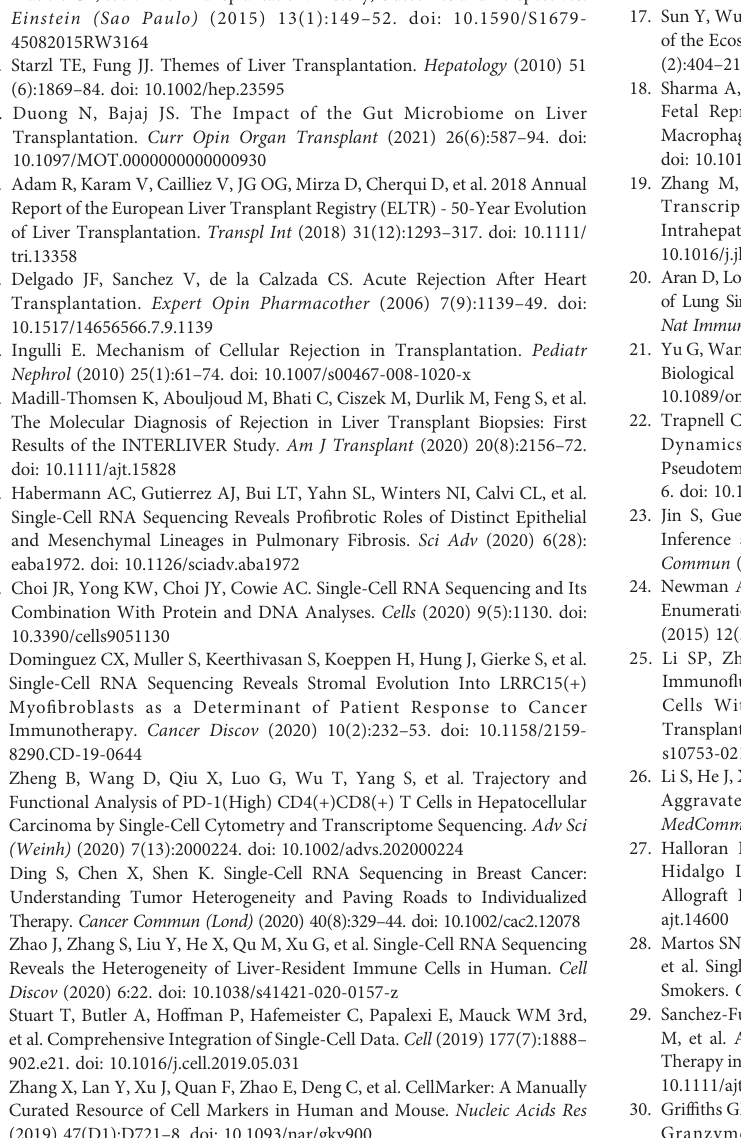
Supplementary Figure 4 | Clustering and analysis of myeloid cells in liver tissue. (A) Fractions ofmyeloid cell subpopulations in normal(n=3) and liver transplantation (n=4) samples. (B) Clustering of 4883 myeloid cells and annotation basically. (C) Pseudotime analysis with identi fi ed 5 dendritic cell groups (colored by pseudotime). Supplementary Figure 5 | Further analysis of exhausted CD8+ T cells. (A) Enrichment analysis of Kyoto Encyclopedia of Genes and Genomes (KEGG) terms for differentially expressed genes in exhausted CD8 T cells. (B) Bulk RNA-seq expression of PDCD1in stable (N, n=129) and rejection samples (R, n=37) after liver transplantation. (C) Pseudotime analysis with identi fi ed 3 subgroups of exhausted CD8+ T cells (colored by pseudotime). (D) Pseudotime analysis with identi fi ed 3 subgroups of exhausted CD8+ T cells (colored by clusters). (E) Estimated